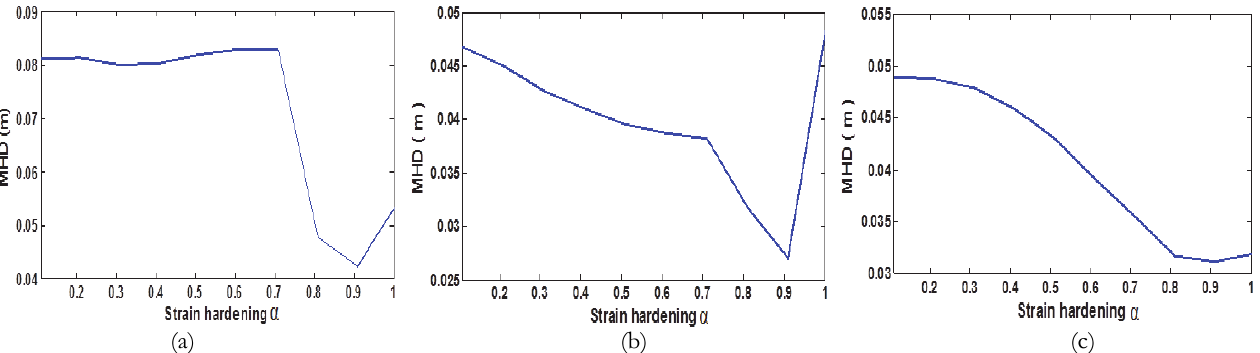
Figure 15: MHD versus variable ( α ) values under different periods T1, (a) T1 = 1.5 sec; (b) T1 = 1.0 sec; (c) T1 = 0.6 sec.